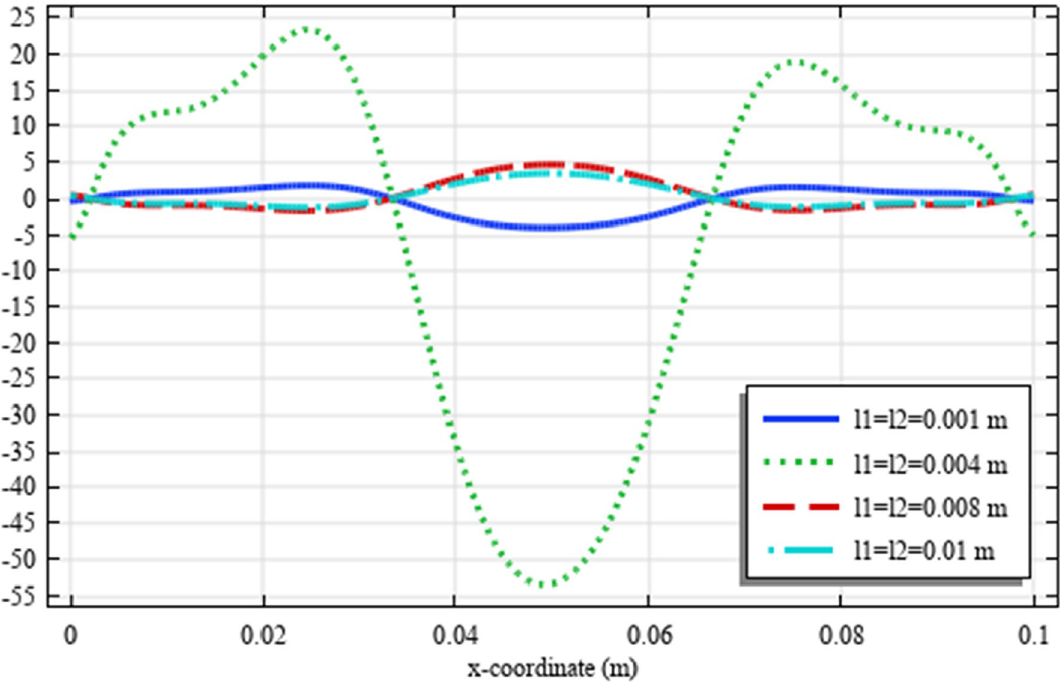
Figure 11. The micro-strain s yy ( x , b / 2 )/ s 0 for different values of ℓ 1 and ℓ 2 (COMSOL Multiphysics).